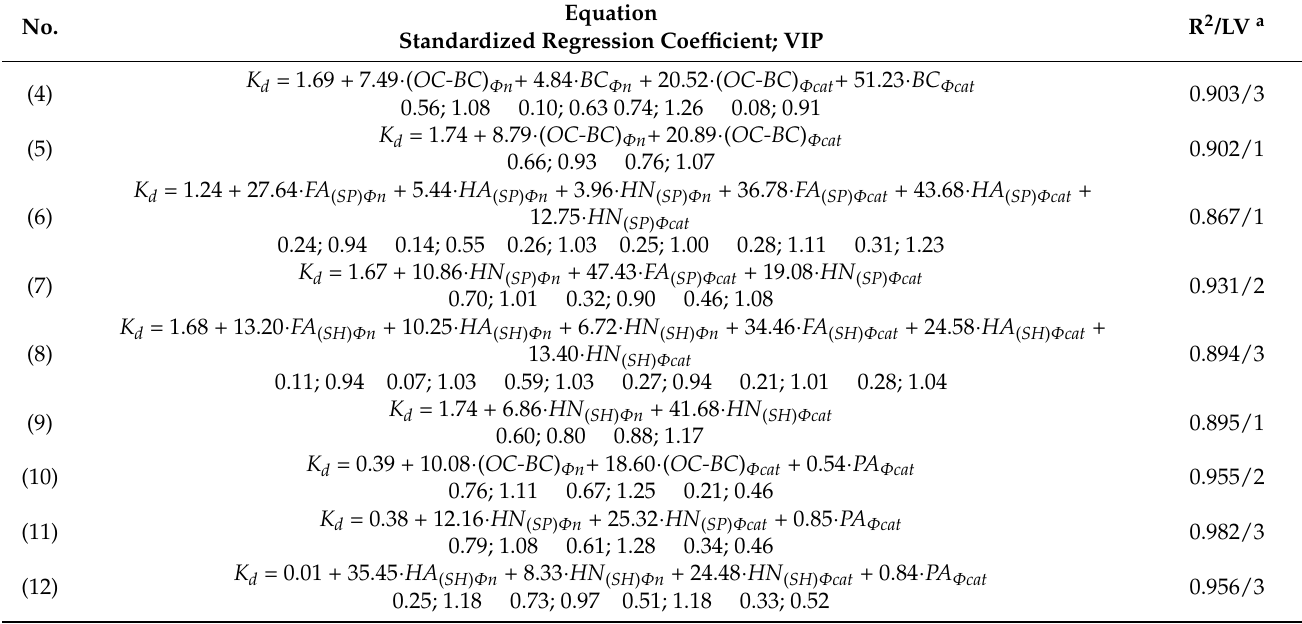
Table 1. This relationship between K d (mL/g) and soil properties according to the PLSR analysis.